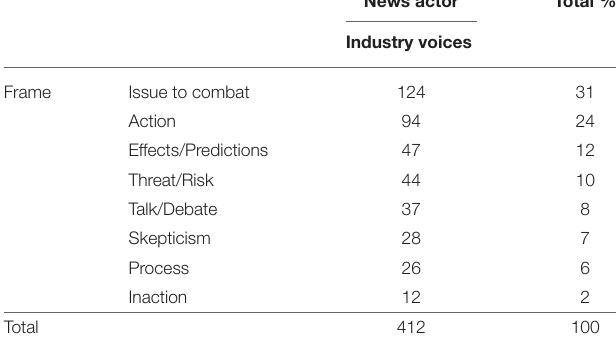
TABLE 2 | Industry voices by frame.